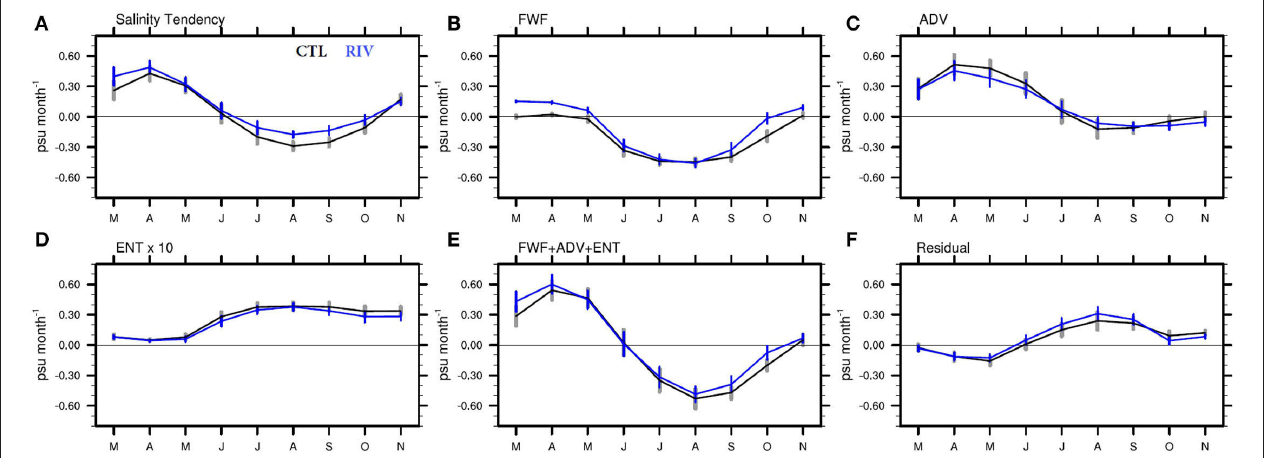
FIGURE 6 | Climatological seasonal cycle of the mixed layer salinity budget terms (psu month − 1 ) averaged over the northern Bay of Bengal (15 ◦ N-23 ◦ N; 80 ◦ E-95 ◦ E) for the CTL (black) and RIV (blue) runs. (A) Salinity tendency (ST), (B) freshwater forcing (FWF), (C) advection (ADV) term, (D) entrainment (ENT, × 10) term, (E) sum of FWF, ADV, and ENT, (F) residual term (ST-FWF-ADV-ENT). Also shown as vertical bars are the monthly standard deviations of the terms over the simulation period